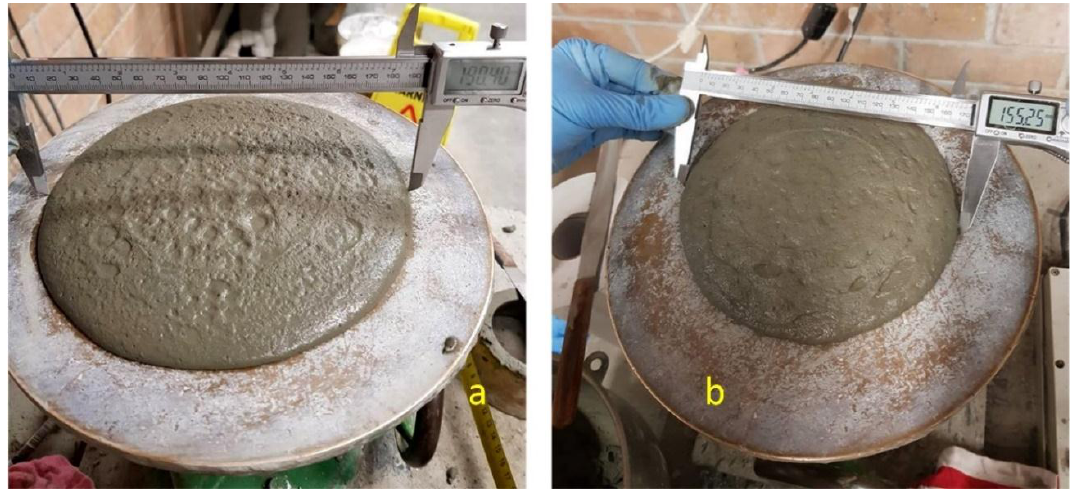
Figure 15. Spread-flow test: ( a ) For trial 5 which did not use fibre; ( b ) for the same trial by adding fibre with 1% polypropylene fibre.